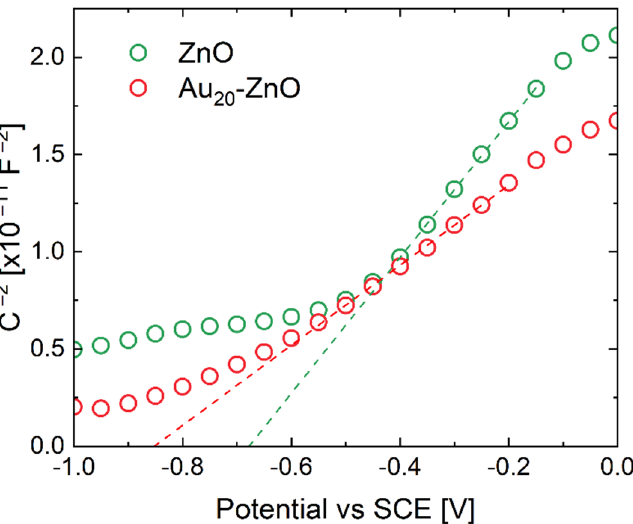
Figure 4. Mott–Schottky plot of ZnO and Au 20 -ZnO in 0.5 M Na 2 SO 4 (dashed lines represent the fits to linear regions).